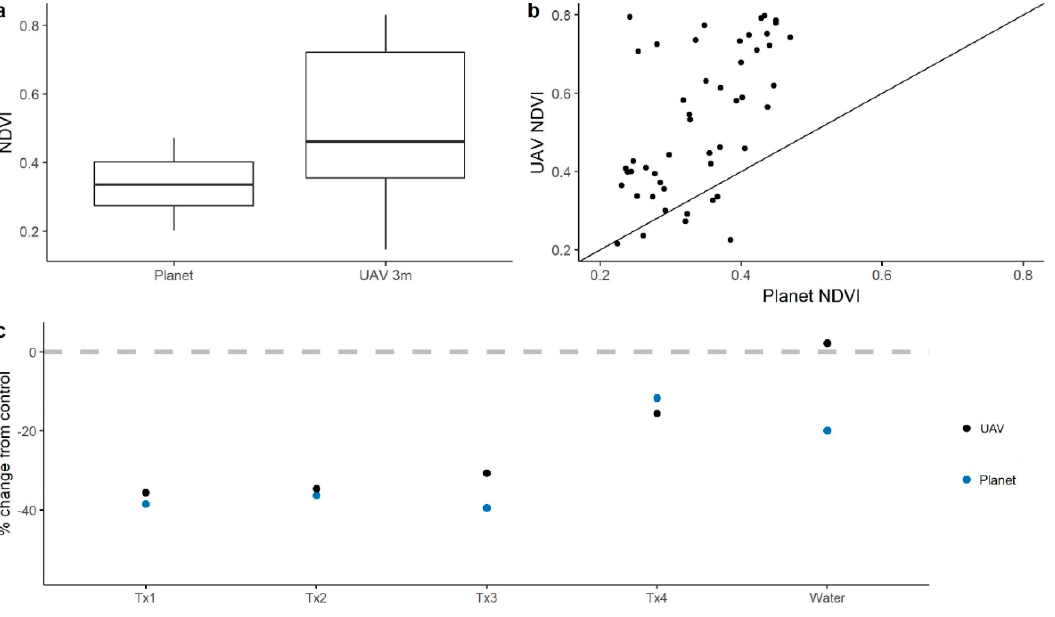
Figure 5. Scaling results comparing UAV data and PlanetScope data: (a) boxplot of NDVI for PlanetScope and UAV resampled to 3 m; (b) correlation between UAV NDVI and PlanetScope NDVI; and (c) % change from control in NDVI value for UAS raw value and PlanetScope.